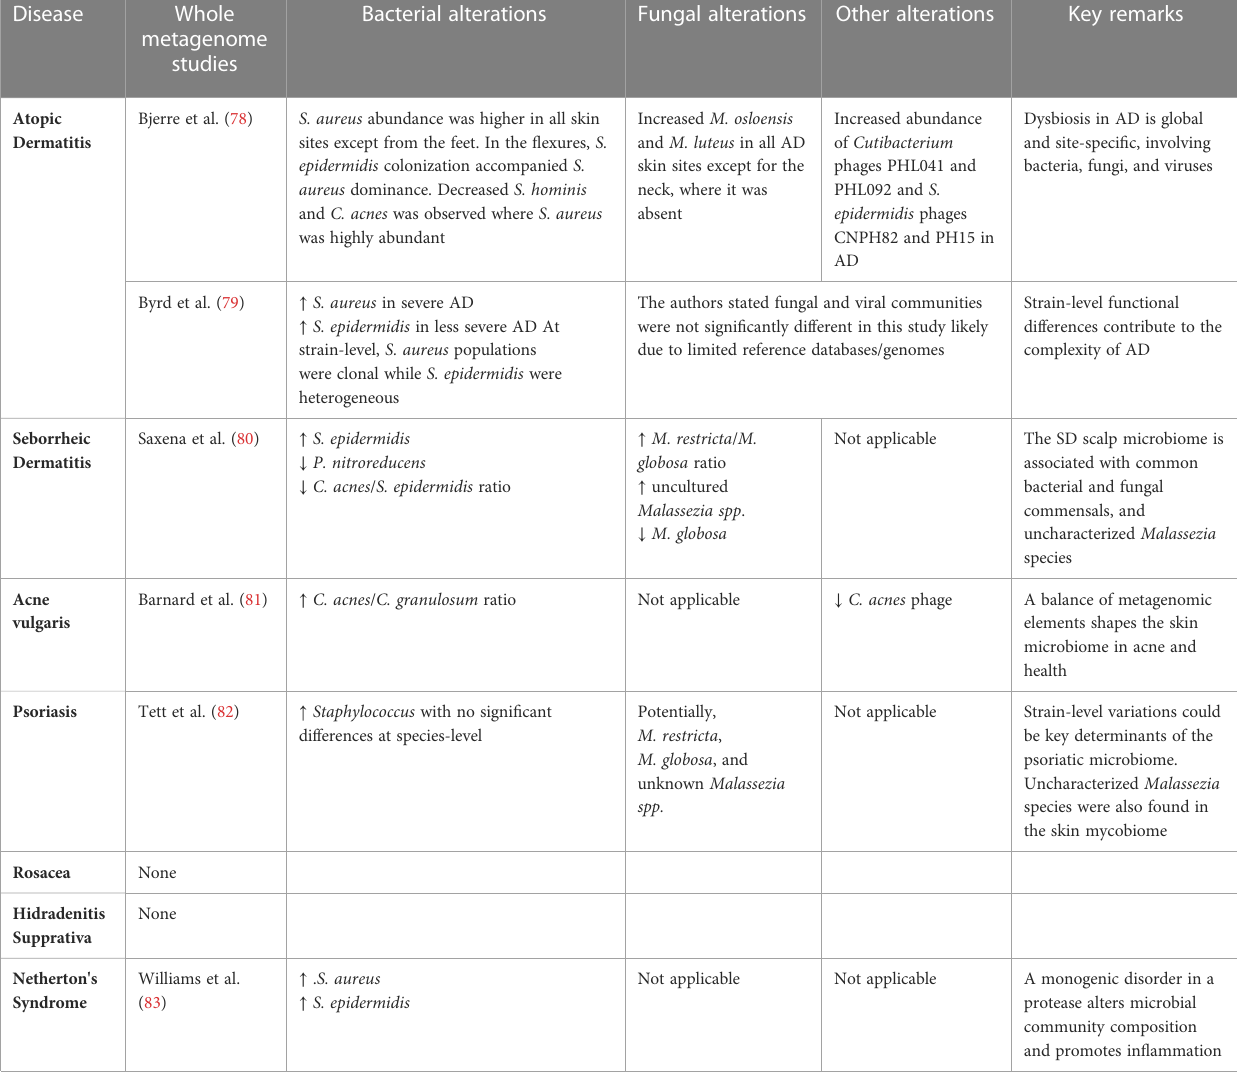
TABLE 1 Recent studies investigating the microbiome in skin disease utilizing whole